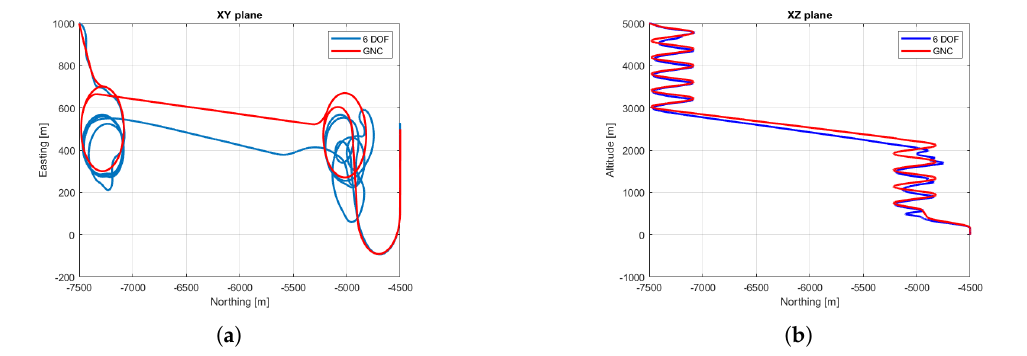
Figure 22. Partial views of the 6 DOF trajectory of the parafoil with control saturation and a windy en-